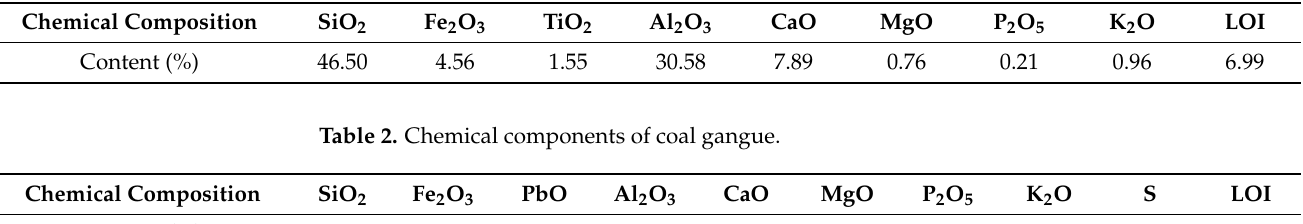
Figure 2. Inductively coupled plasma spectrometer. Table 1. Chemical components of fly ash.